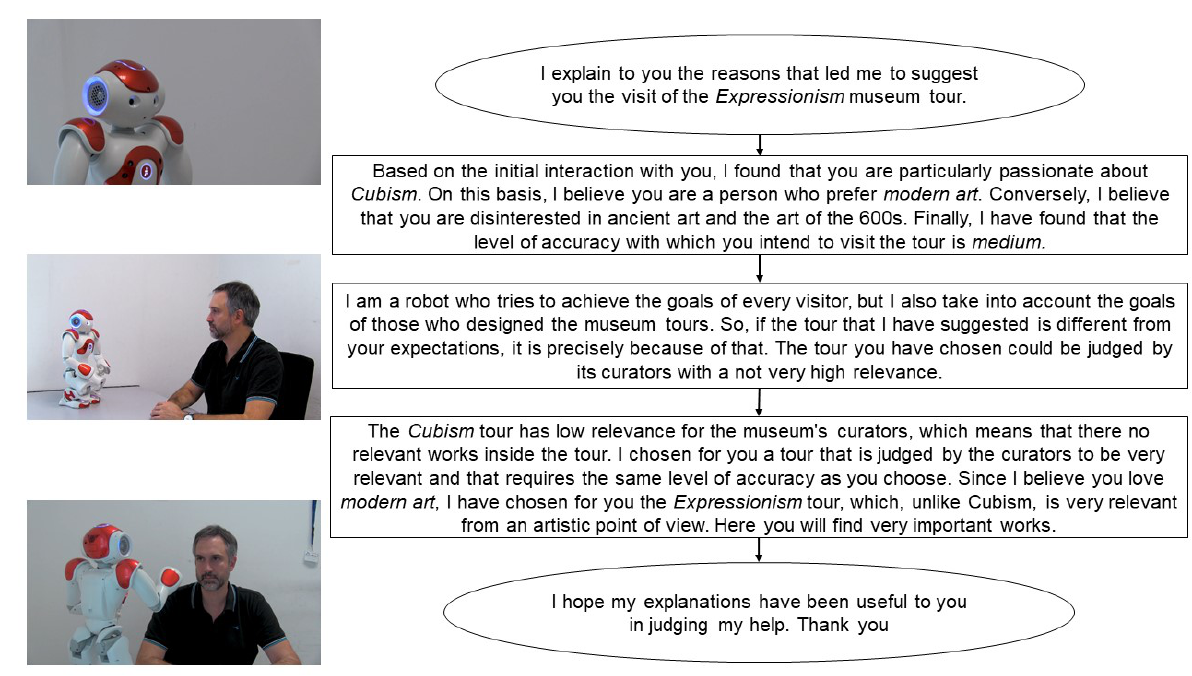
Figure 9. Example of the explanation provided to user